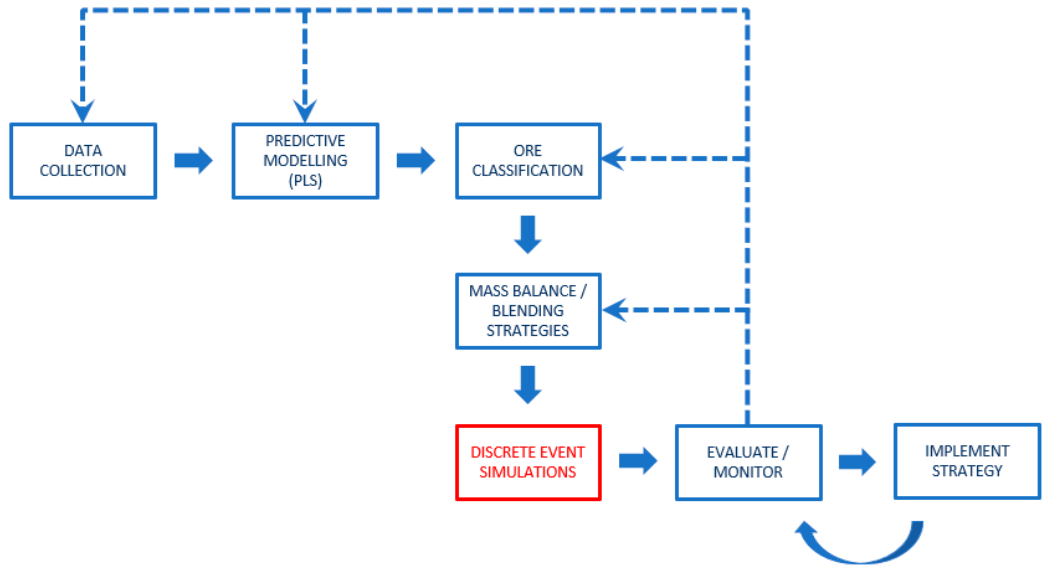
Figure 4. Generalized diagram showing the implementation of discrete event simulations (DES) in the formulation of blending control strategies and related operational modes.